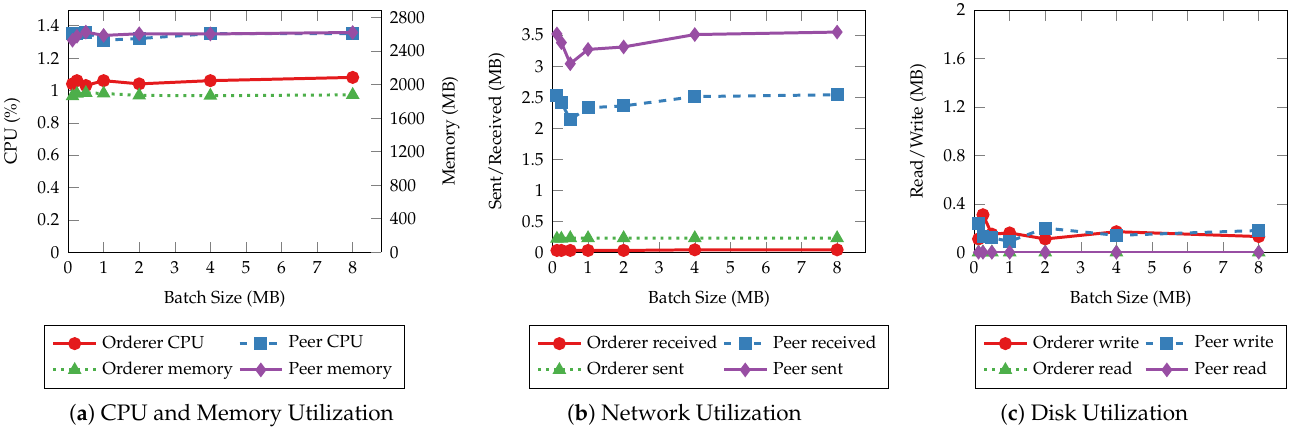
Figure 13. The average CPU and memory usage ( a ), total data received from and sent to the network ( b ), total data written to and read from disk ( c ) of orderer and peer nodes for handling “querying a service request” operations with varying batch